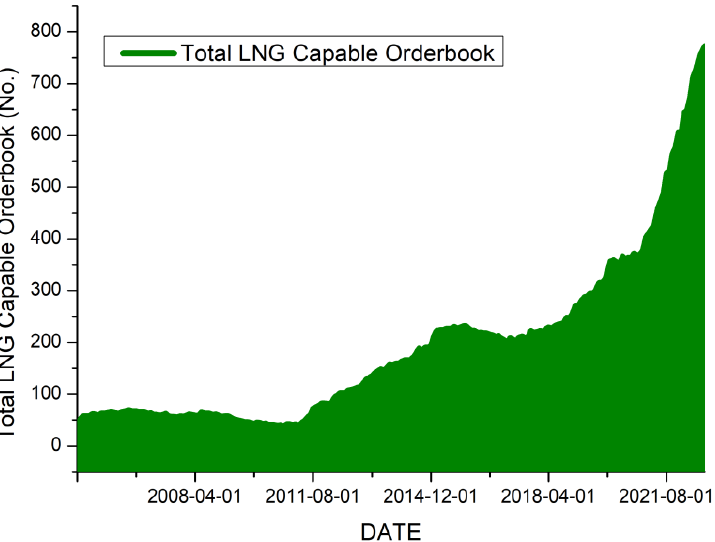
Figure 1. LNG-capable orderbook trend (adapted from Clarkson research [5]). LNG, liquefied natural gas.